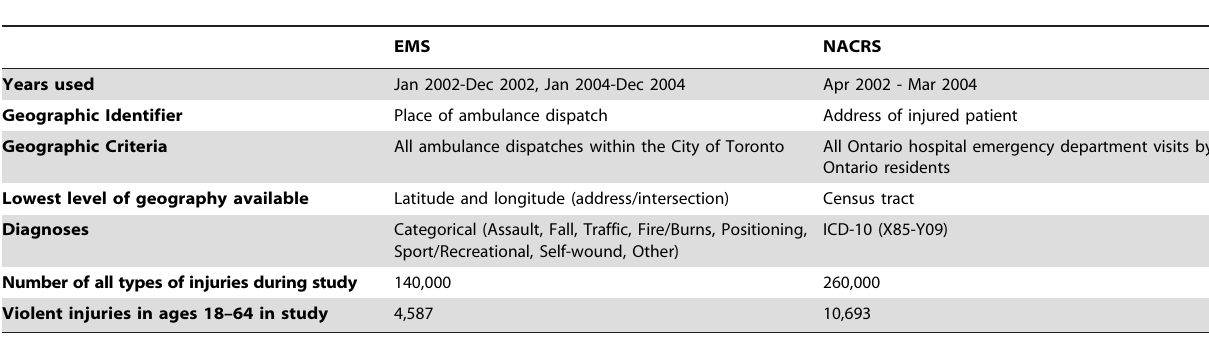
Table 1. Selected characteristics of EMS and NACRS